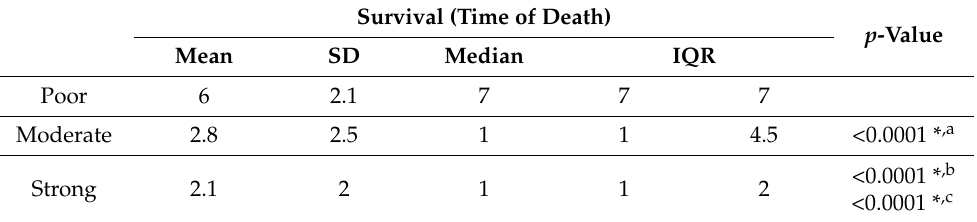
Table 3. Time to death (Survival) of Galleria mellonella injected by biofilm-producing carbapenem resistant Acinetobacter baumannii isolates from ICU patients with